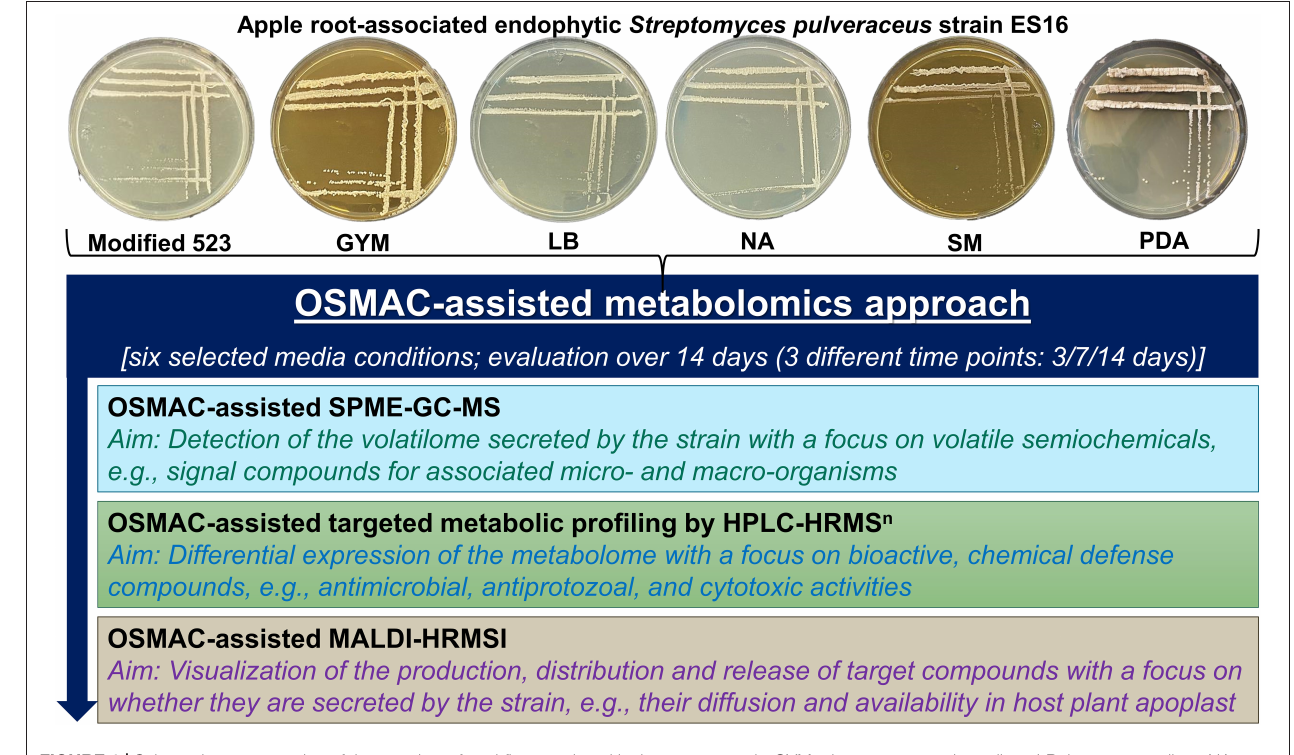
(Blastn) (Zhang et al., 2000) against the NCBI database (https://www.ncbi.nlm.nih.gov/), and submitted (accession no.